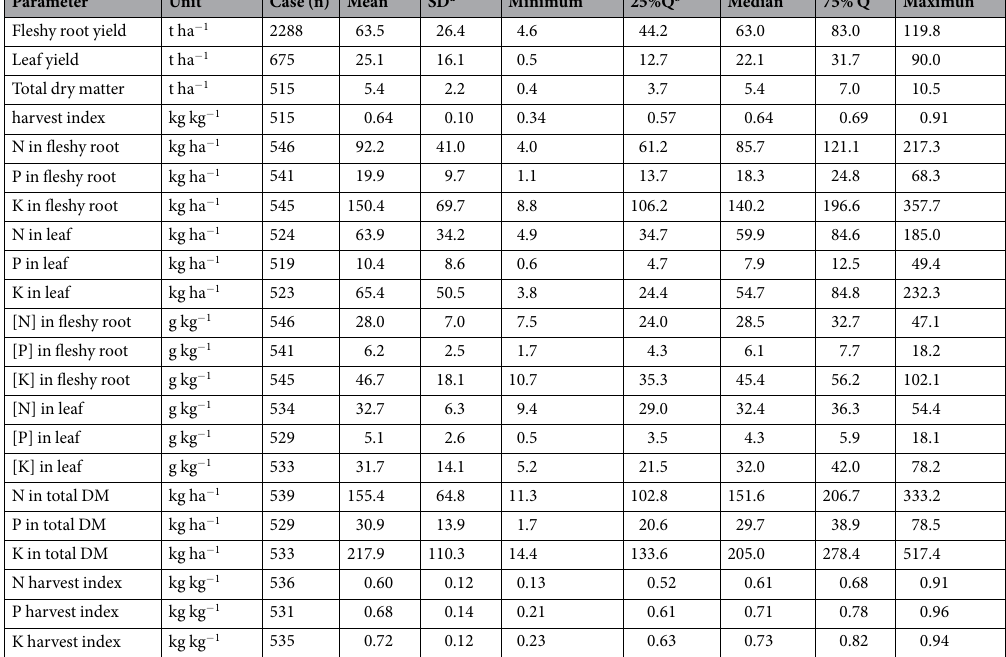
Table 2. Radish characteristics, including fleshy root and leaf yield (fresh weight), total dry matter (DM), harvest index, N, P, and K accumulation in fleshy root, leaf, and total plant DM, concentrations of N [N], P [P], and K [K] in fleshy root and leaf, and nutrient harvest index (kg nutrient in fleshy root per kg nutrient in total plant DM). a SD, standard deviation. b Q,